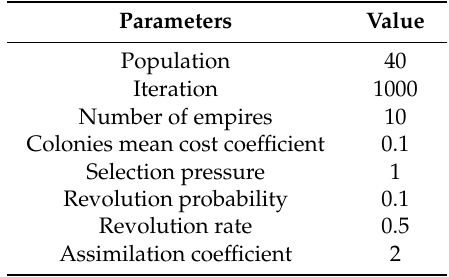
Figure 13. Result of the RBF-ICA model: a) Altitude b) Aspect c) Slope d) Distance to road e) Distance to s ettlement f) Rainfall g) Temperature h) Wind effect.